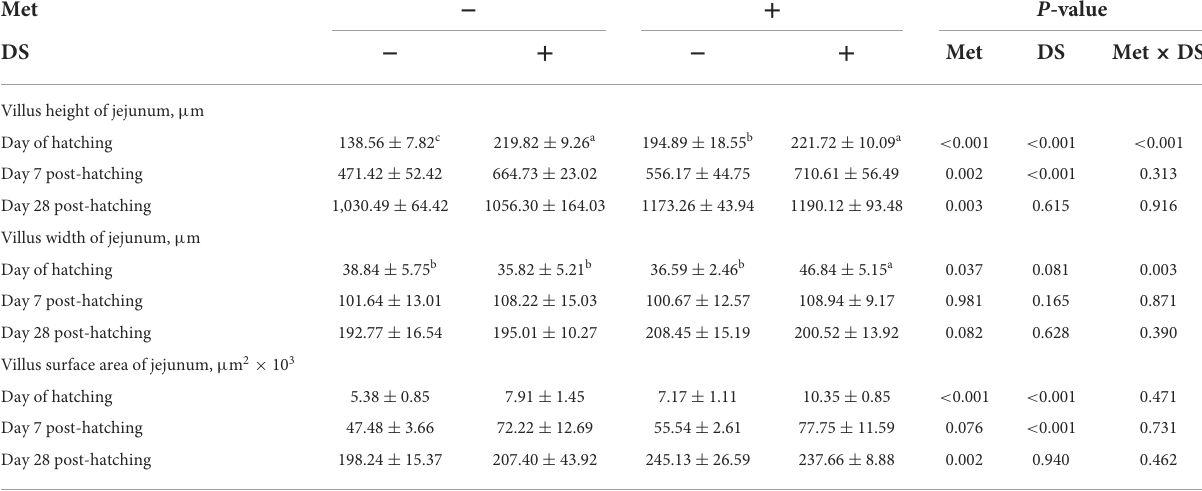
TABLE 9 Effects of in ovo injection of methionine (Met) and disaccharide (DS) on jejunum parameters of geese during the early-life post-hatching 1,2 .